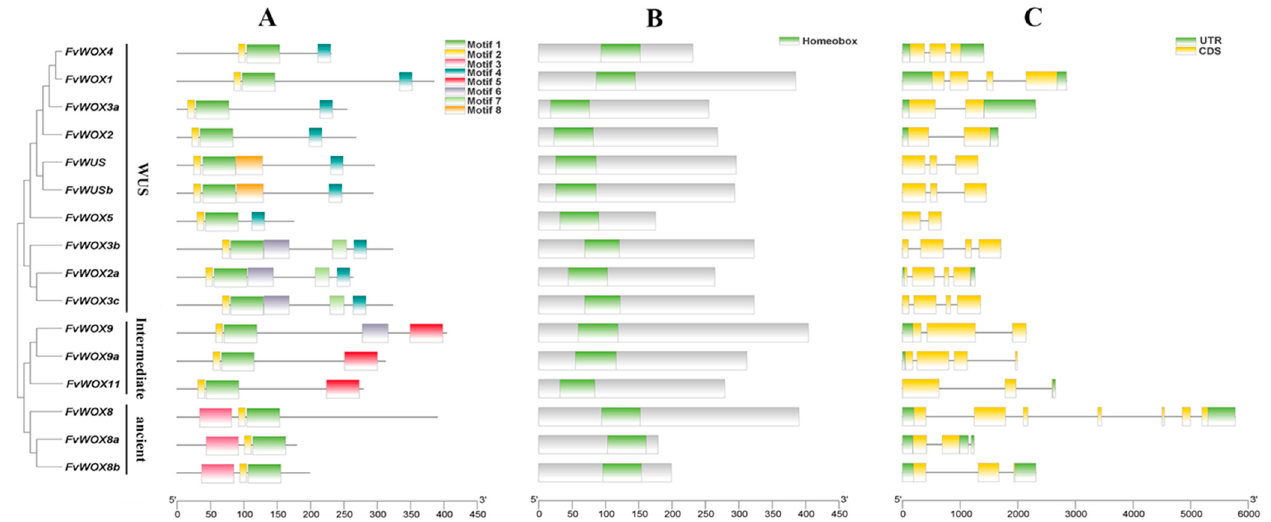
Figure 3. Protein and gene structures of FvWOXs. ( A ) Schematic diagram of the conserved motifs of FvWOX proteins. Different colored boxes represent different conserved protein motifs. ( B ) Positions of the HB domain in each FvWOX protein. ( C ) The exon-intron structures of FvWOX genes: the yellow box indicates the exon, the black line indicates the intron, and the green box indicates the untranslated 5 ′ - or 3 ′ -region.